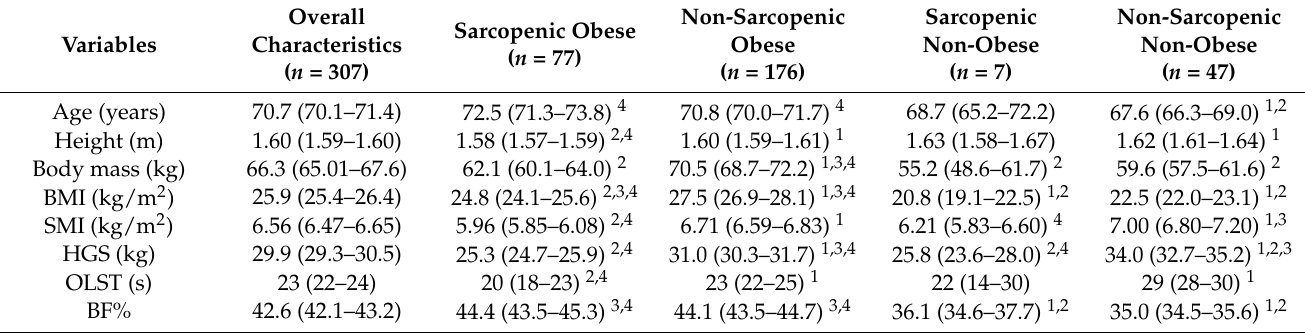
Table 1. Physical, sarcopenic, and obesity-related characteristics among groups.